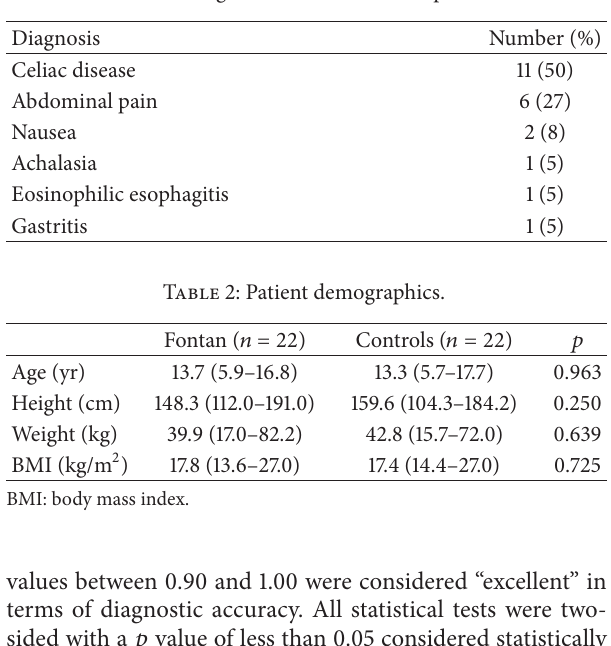
Table 1: Diagnoses of the 22 control patients.